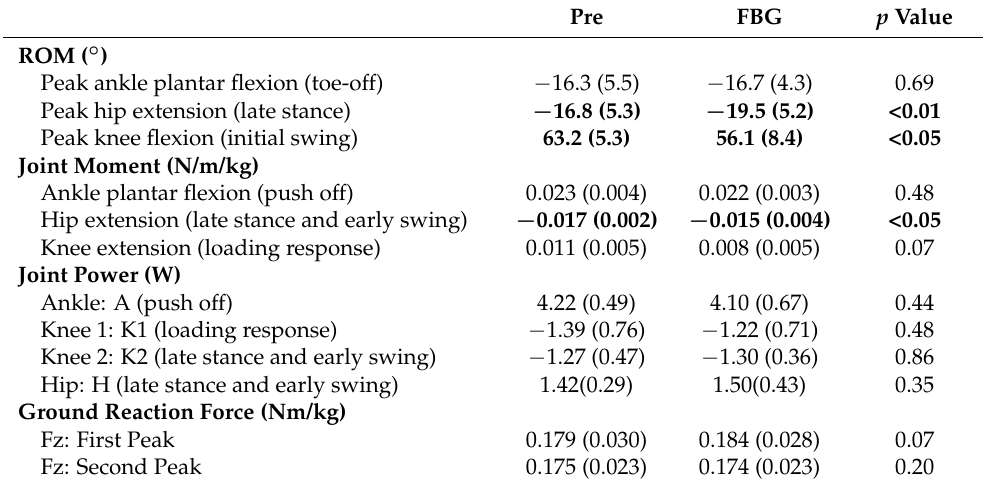
Table 3. Kinematics Kinetics data, and Ground reaction force during walking pre and post wearing of FBG. average (SD), paired t -test, p values < 0.05 are bolded.